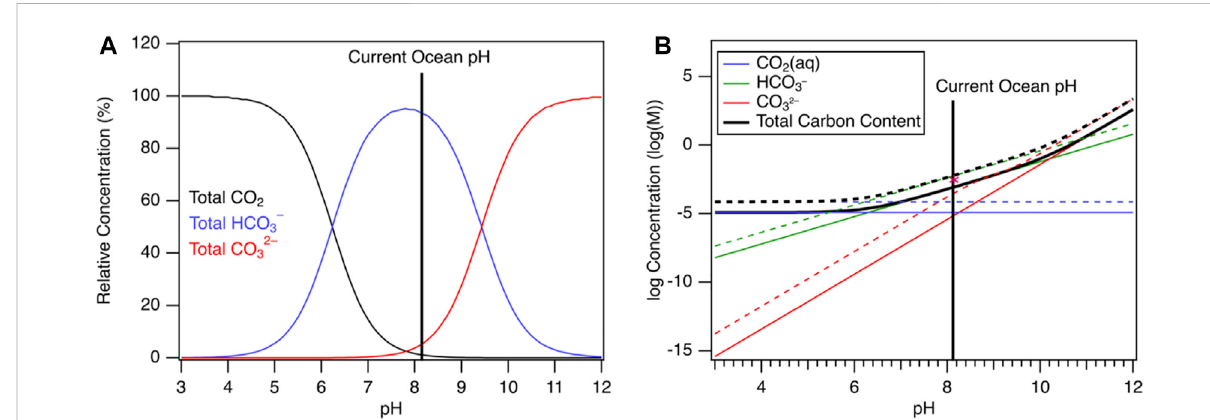
FIGURE 2 (A) Bjerrum plot showing the speciation of dissolved inorganic carbon in a background of seawater (Riebesell et al., 2010) at fi xed total carbon concentration at 25 ° C (B) CO 2 speciation vs pH for pure (solid lines) and seawater (Riebesell et al., 2010) (dotted lines) at fi xed partial pressure in an open CO 2 system at 25 ° C. Calculations were performed with ChemEQL (Müller, 2015). The asterisk denotes the total carbon content of water as calculated in Ref. (Riebesell et al.,